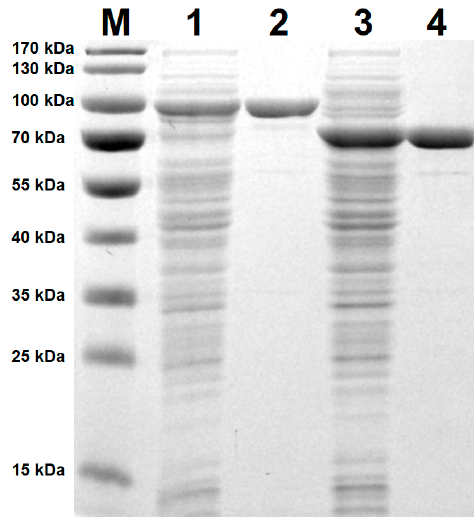
Figure 2. SDS-PAGE analysis of induced and purified recombinant PsLam81A and PsLam81A Δ CBM56 proteins. Lane M—Molecular mass, lane 1—soluble protein fraction of induced E. coli strain BL21 (DE3) cells carrying pLATE31-PsLam81A plasmid, lane 2—purified